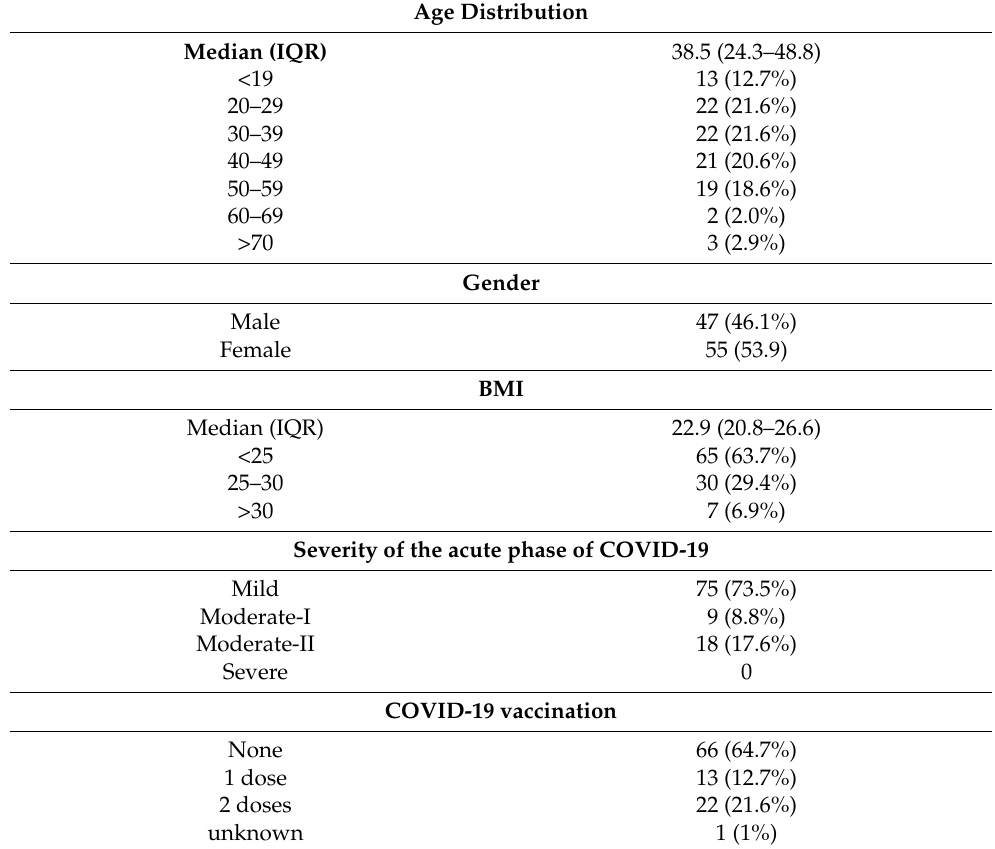
Table 1. Backgrounds of 102 patients who visited the COVID-19 aftercare outpatient